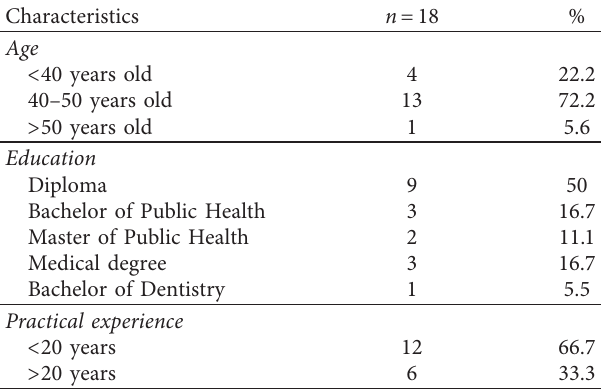
Table 1: Characteristics of